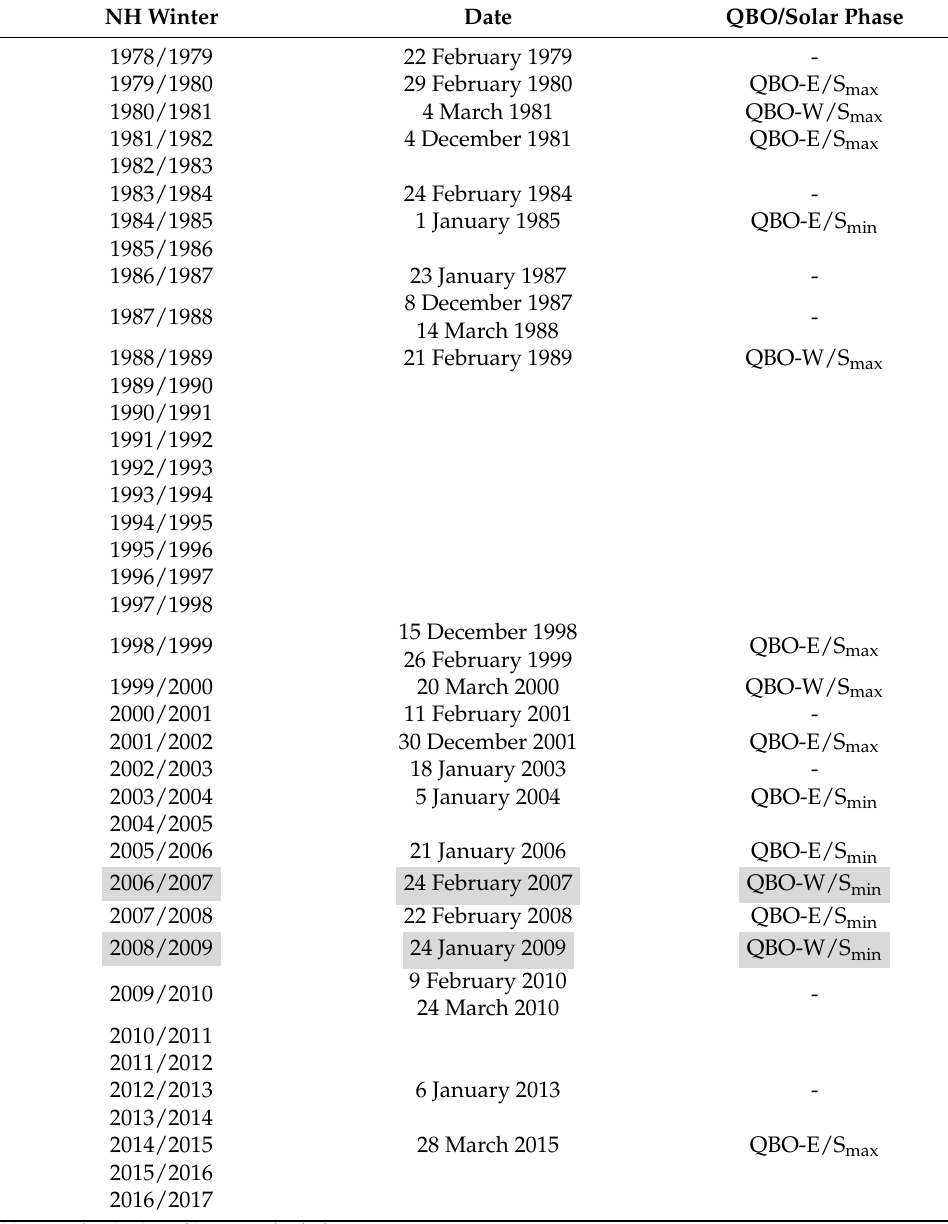
Table 1. Central dates of sudden stratospheric warmings (major warmings) in Northern Hemisphere Winters diagnosed from ERA-Interim data.